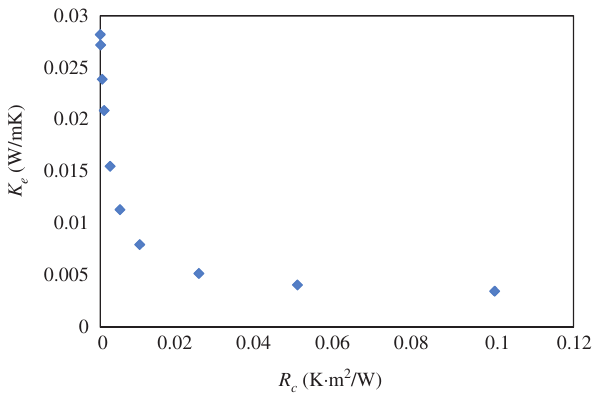
Figure 10 Effective thermal conductivity of cotton/air with the interface thermal contact resistance (by